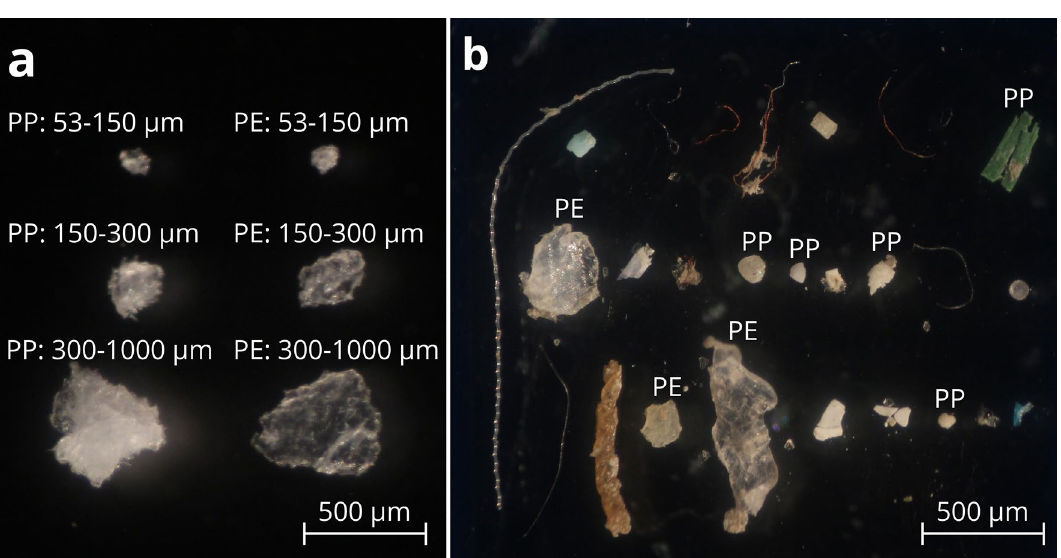
Figure 1. Manufactured and field sampled microplastic fragments. Micrographs: ( a ) Polypropylene (PP) and polyethylene (PE) microfragments from each size class produced using the microfragment production protocol; ( b ) Polypropylene and polyethylene microfragments sampled in the Delaware Bay. Field sample polymer types confirmed by micro-FTIR (Spotlight 200i